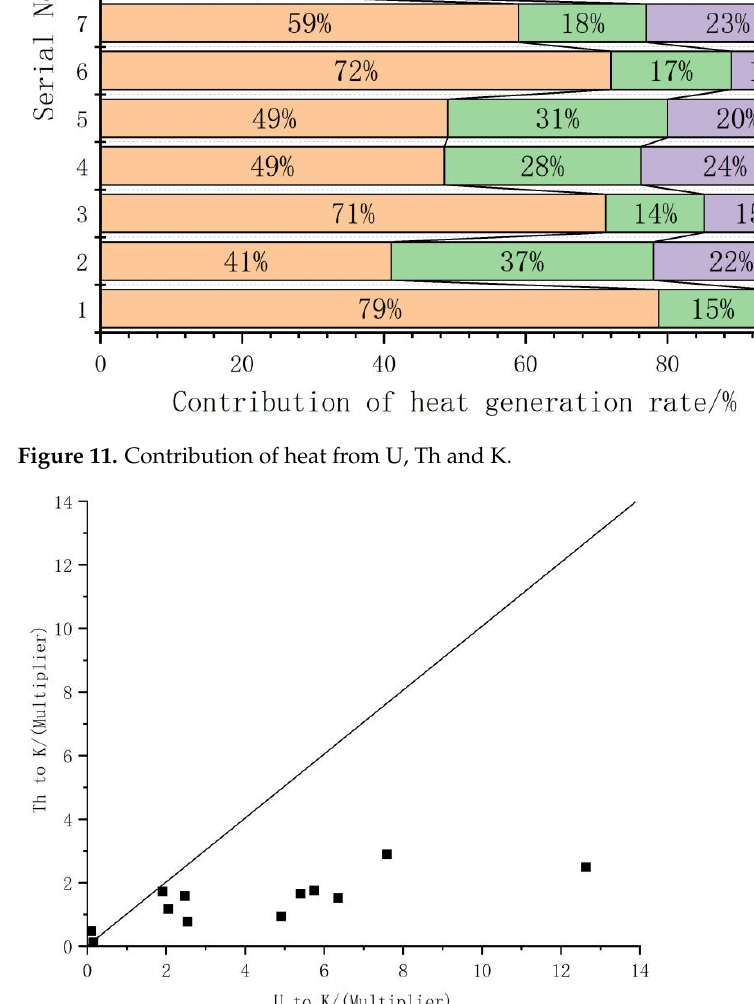
Figure 12. U, Th to K heat contribution multiplier chart. 5.4. Vertical Characteristics of the Geothermal Field Three drilled wells (DR1, DR6 and DR7) in Xiong’an New Area’s Rongcheng Bulge were analyzed to reveal the thermal state of the strata at different depths. The part above 800 m in the DR1 well is the sediment cover layer with a high geothermal gradient, and the temperature increases significantly with depth; the geothermal gradient is 74.75 °C/km. At 800–2500 m is the carbonate thermal reservoir; the temperature in this part changes less with depth, and the geothermal gradient is lower compared with the sedi- mentary cover layer at only 4.06 °C/km. The temperature profile of the DR6 well also changes more obviously, and the change pattern is basically the same as that of the DR1